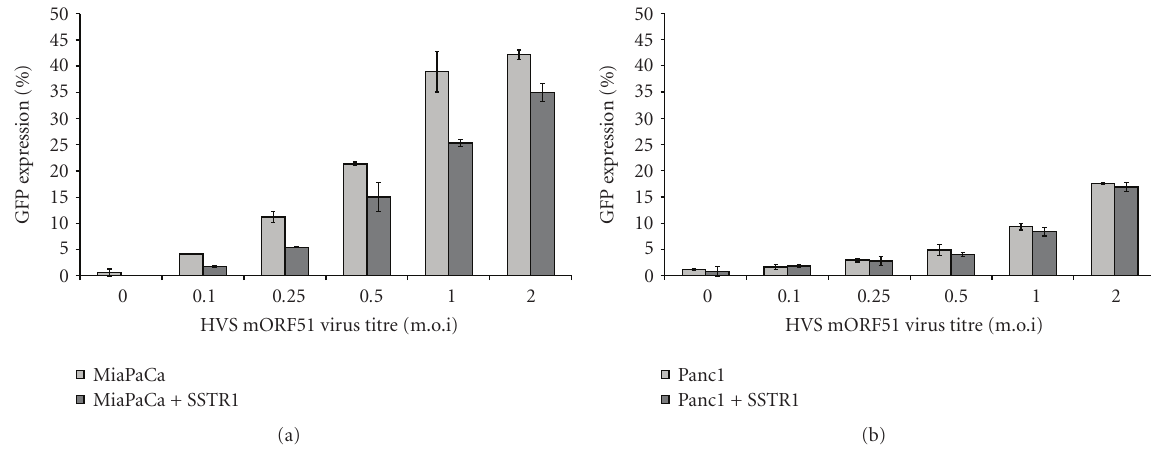
Figure 9: Somatostatin receptor 1 is not required for HVS mORF51 cell entry. Two pancreatic cancer cell lines (MiaPaCa, and Panc1) were stably transfected with a construct expressing the SSTR1 gene. 48 h after infection with HVS mORF51, the cell lines expressing SSTR1 showed no increase in GFP expression as measured by flow cytometry, indicating that the recombinant virus does not interact with this receptor to enter the cell ( n = 2).